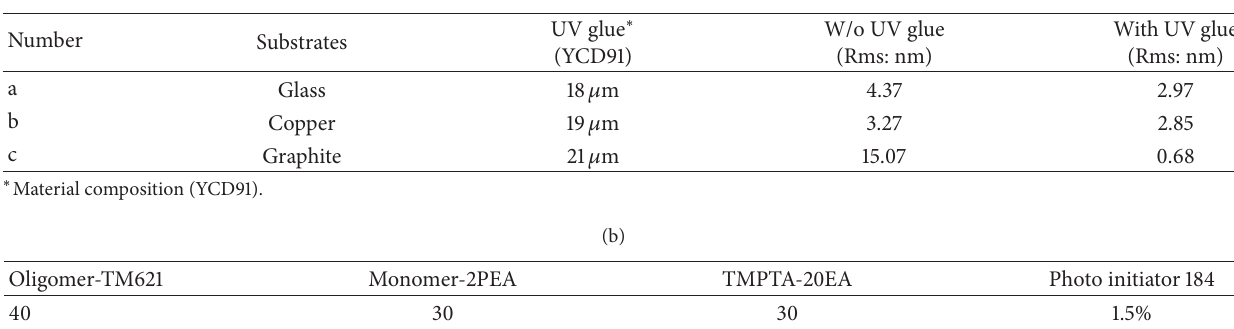
Table 1: Surface roughness characteristics of different